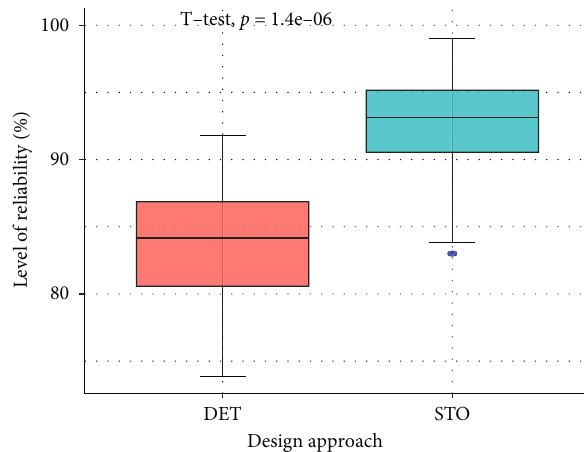
Figure 23: Comparison of design methodology based on system reliability. Table 9: Characteristics examined in the sensitivity analysis.